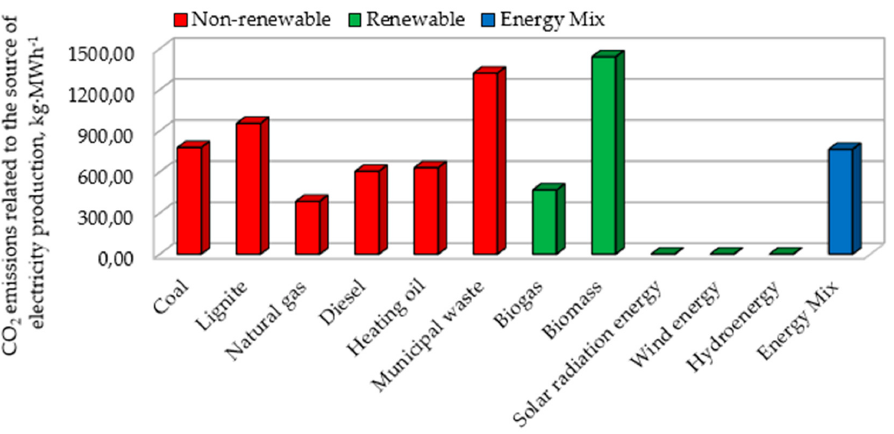
Figure 4. Carbon dioxide emissions depending on the source of electricity production.